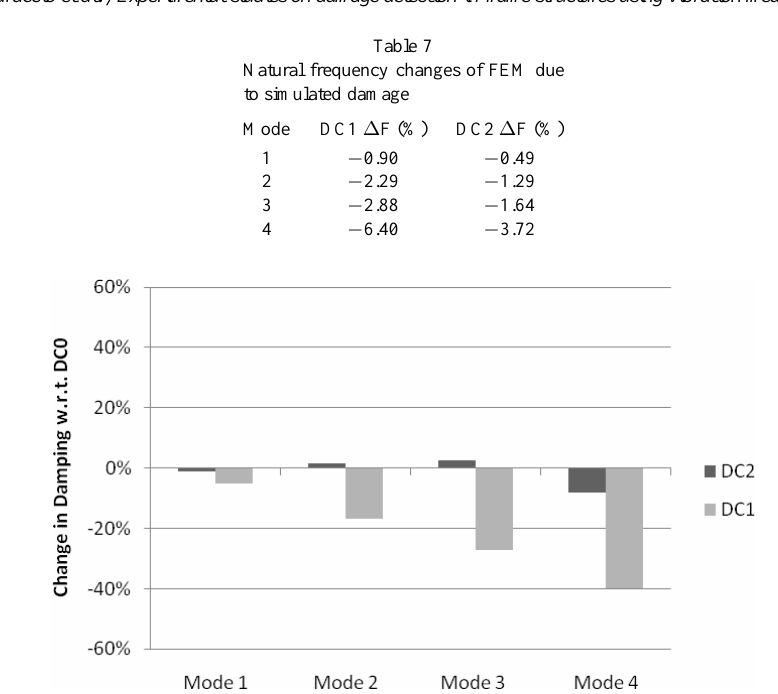
Fig. 19. Change in identified modal damping ratios due to damage